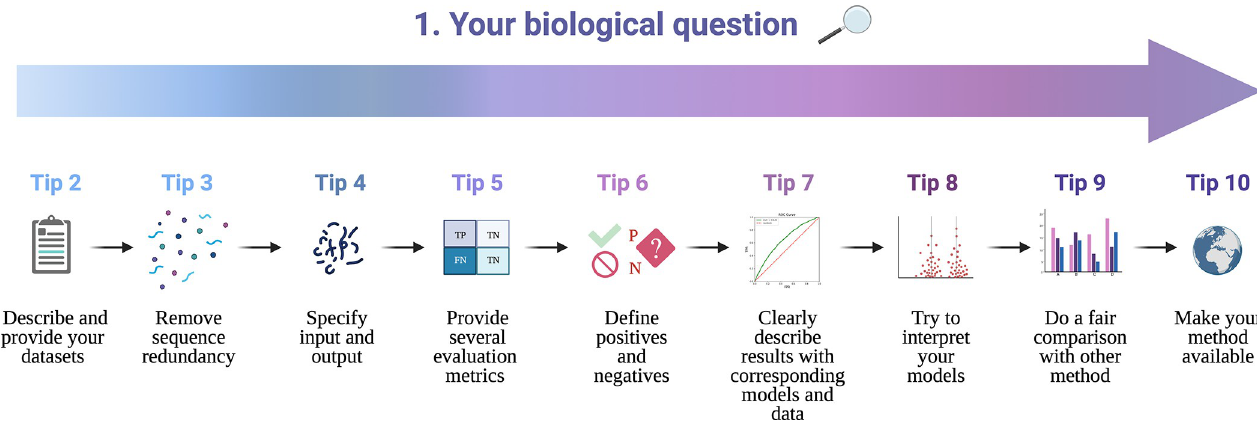
Fig 2. Flowchart of good practices. The main tips on data preparation and benchmark methodology to follow to ensure the usefulness and reproducibility of your work. Created with Biorender.com.